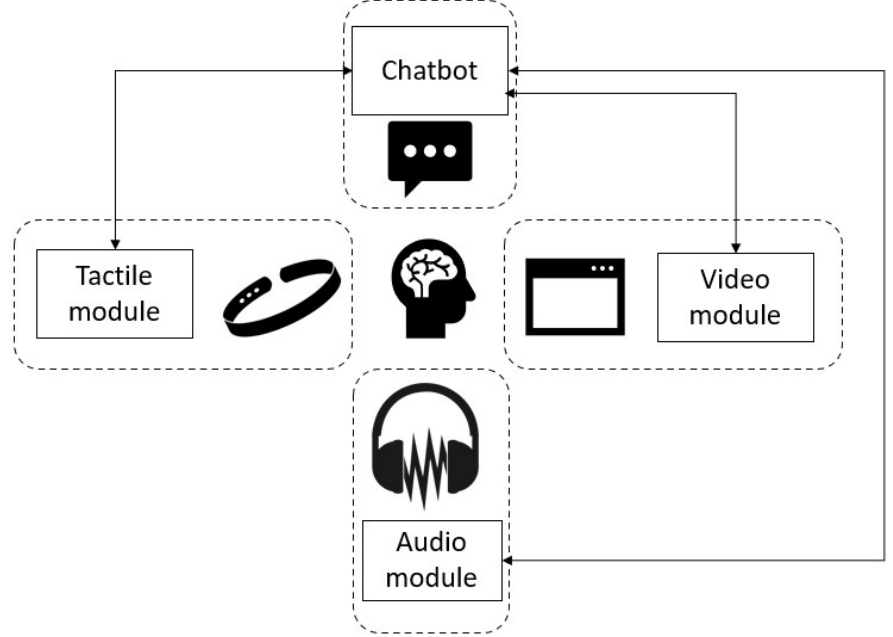
Figure 1. The EMDR system.